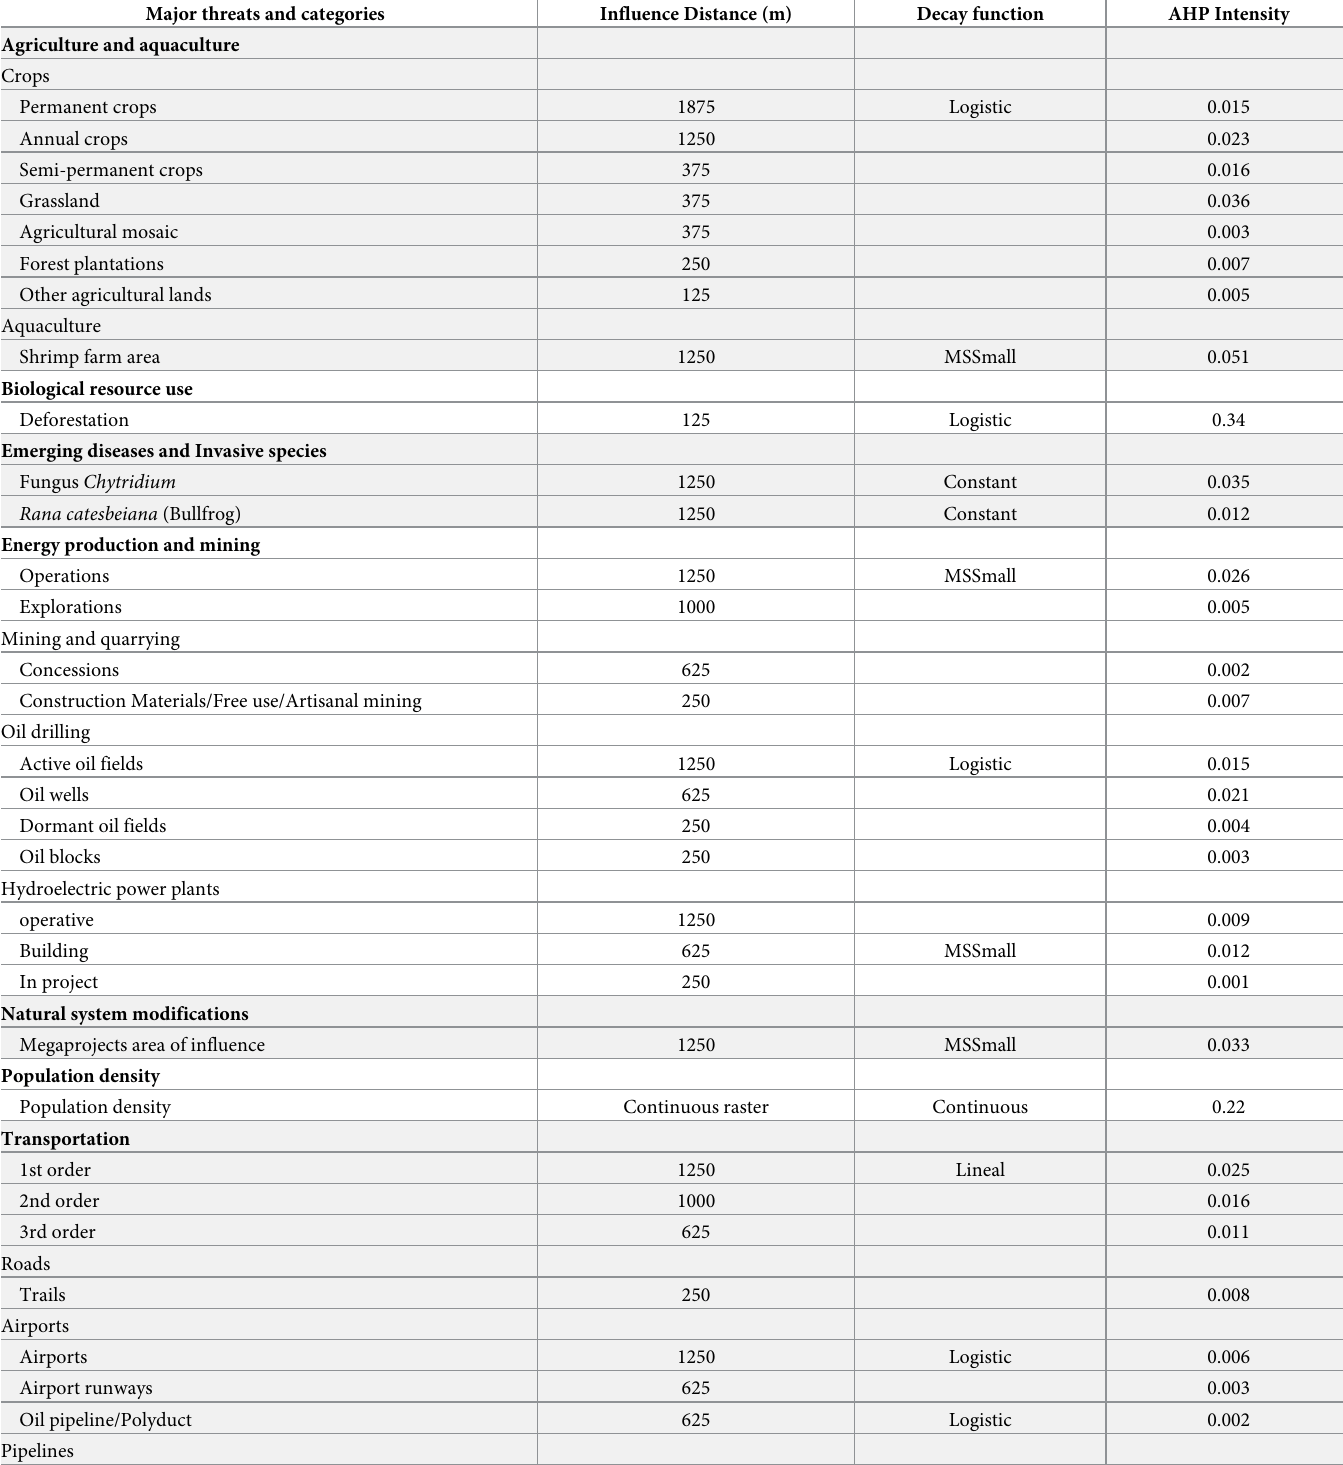
Table 1. Major threats with their subcategories, influence distance, decay function, and Analytic Hierarchy Process (AHP) intensity value estimated for modeling threats to Ecuadorian